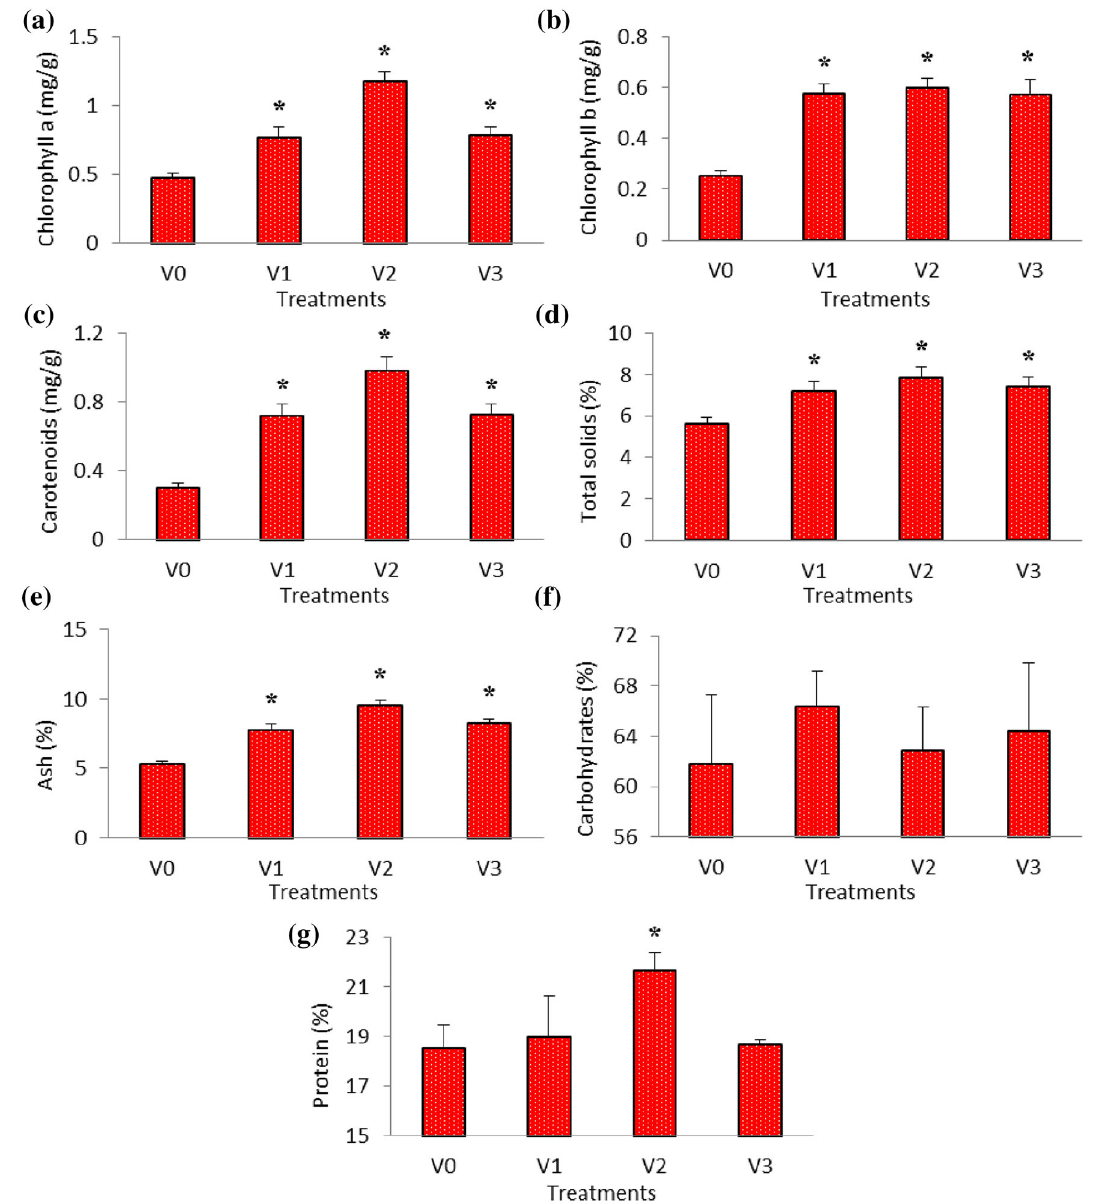
Fig. 3 Effect of salvinia vermicompost on a chlorophyll ‘a’; b chlorophyll ‘b’; c carotenoids content of ladies finger leaves and d total solids; e ash; f carbohydrates and g protein content, of ladies